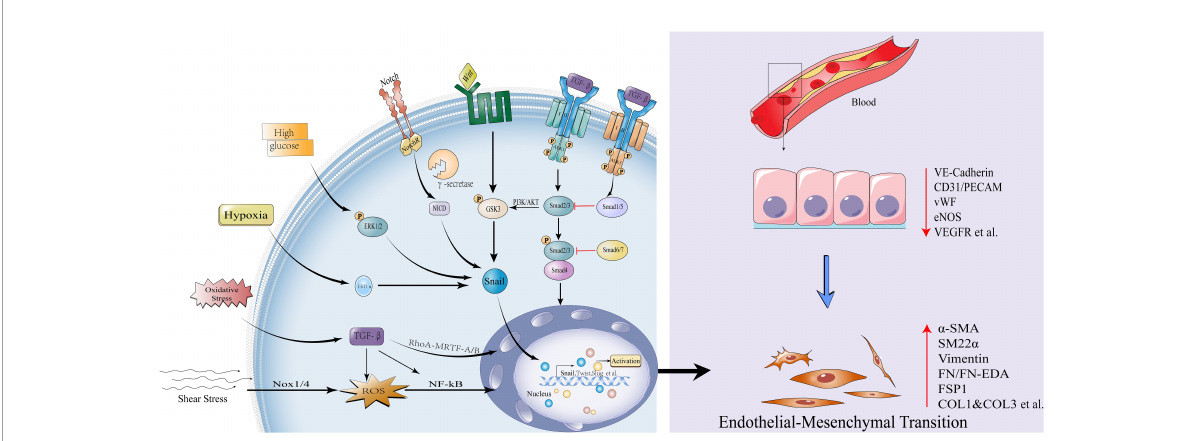
FIGURE1 Influencing factors and canonical signaling pathways of endothelial-mesenchymal transition. Transforming growth factor- β (TGF- β ) signal is initiated, type II receptor activates type I receptor ALK1, phosphorylates Smad2/3, and the latter combines with Smad4 to form a complex into the nucleus to activate transcription factors Snail, Twist1, Slug et al., promoting EndMT; While the type II receptor activates the type I receptor ALK5 and inhibits EndMT via Smad1/5; Smad6/7 also inhibits EndMT by Smad2/3; The non-Smad pathways activated by TGF- β include: PI3K/Akt, Rho GTPase, etc. Other pathways that activate EndMT: Wnt/ β -catenin and Notch signaling pathways. High glucose, hypoxia, oxidative stress, and shear stress can all activate the EndMT process through various mechanisms. EndMT manifests as loss of endothelial markers: Vascular endothelial cell-cadherin, VE-cadherin, Platelet endothelial cell adhesion molecule-1, CD31/PECAM, von Willebrand Factor, vWF, endothelial Nitric Oxide Synthase, eNOS, Vascular endothelial growth factor receptor, VEGFR; Obtainment of mesenchymal markers: Actin alpha 2, α -SMA/ACTA2, Smooth muscle 22 α , SM22 α , Vimentin, Fibronectin, FN/FN-EDA, Fibroblast-specific protein 1, FSP1, Collagen Type I and Collagen Type 3, COL1 and COL3